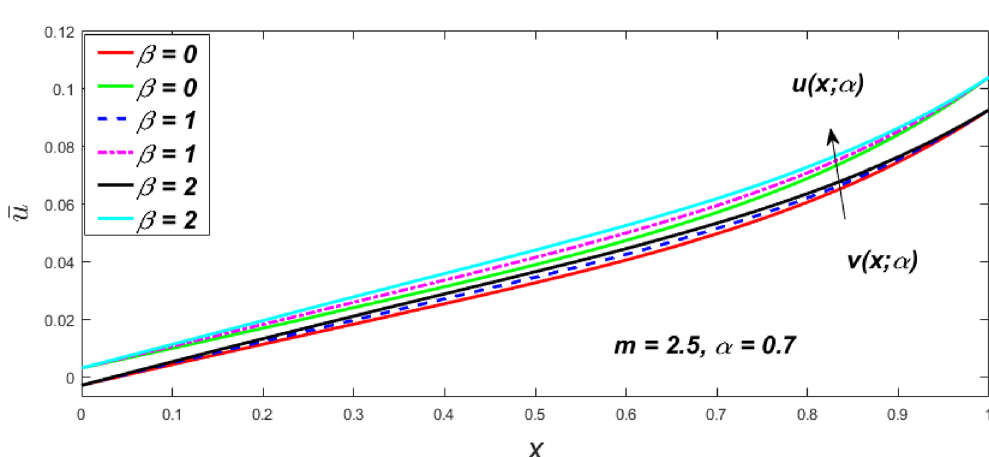
Figure 9. Fuzzy velocity profiles for the impact of β